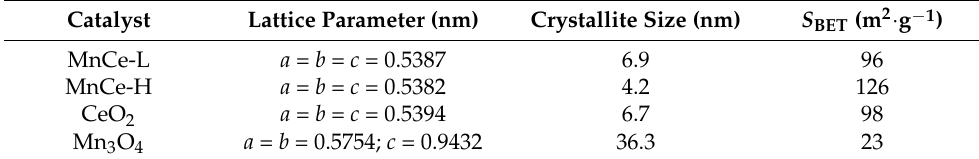
Figure 2. ( a ) XRD patterns and ( b ) Raman spectra of (1) MnCe-L, (2) MnCe-H, (3) CeO 2 and (4) Mn 3 O 4 . Table 1. Structural properties of the